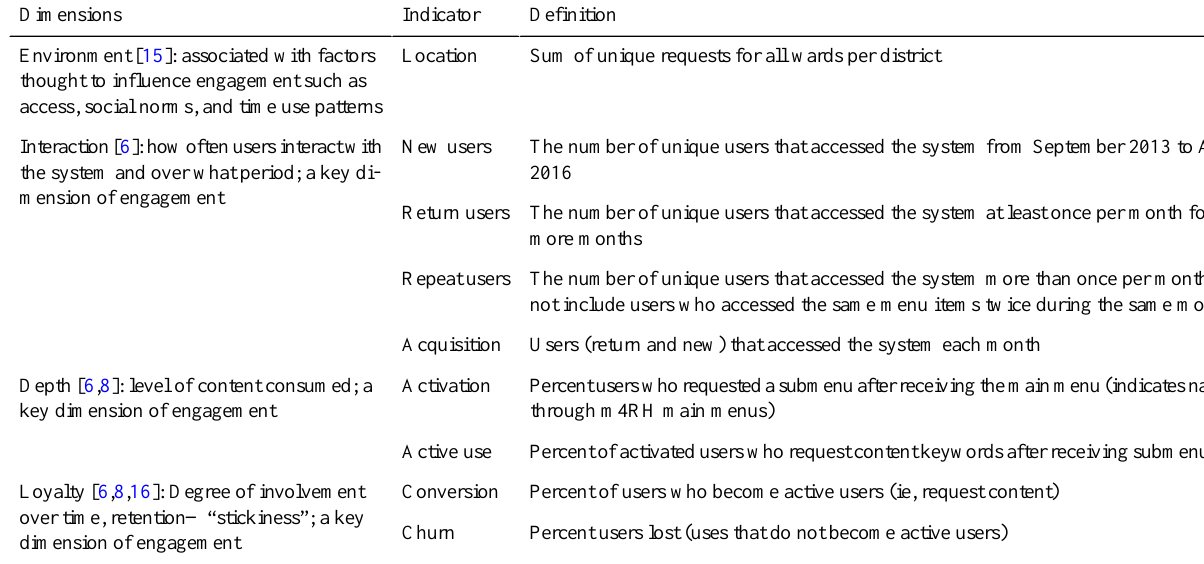
Table 1. Definitions pertaining to user engagement attributes.